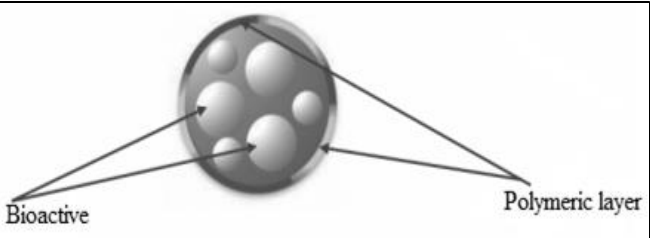
Figure 1: Illustrative image of a natural asset encapsulated by polymeric nanoparticles.